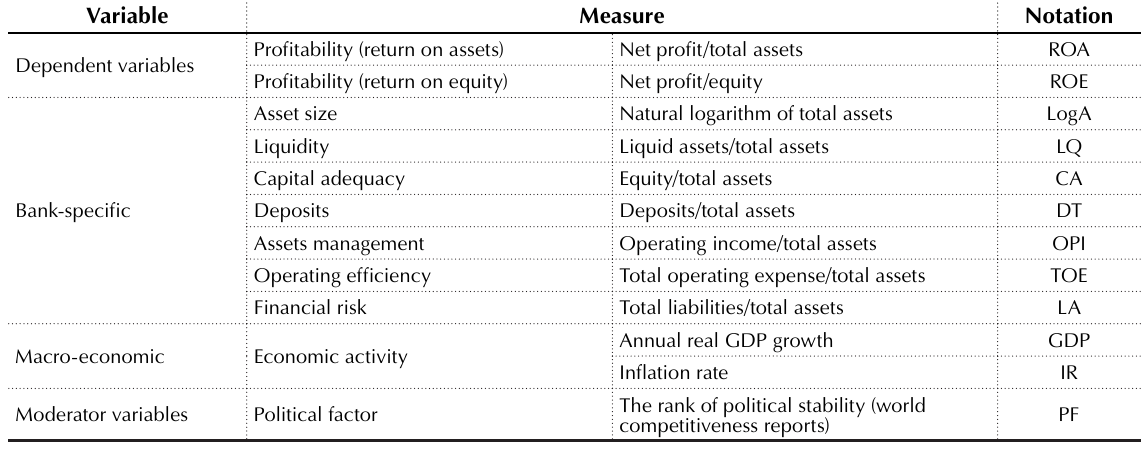
Table 1. Study variable